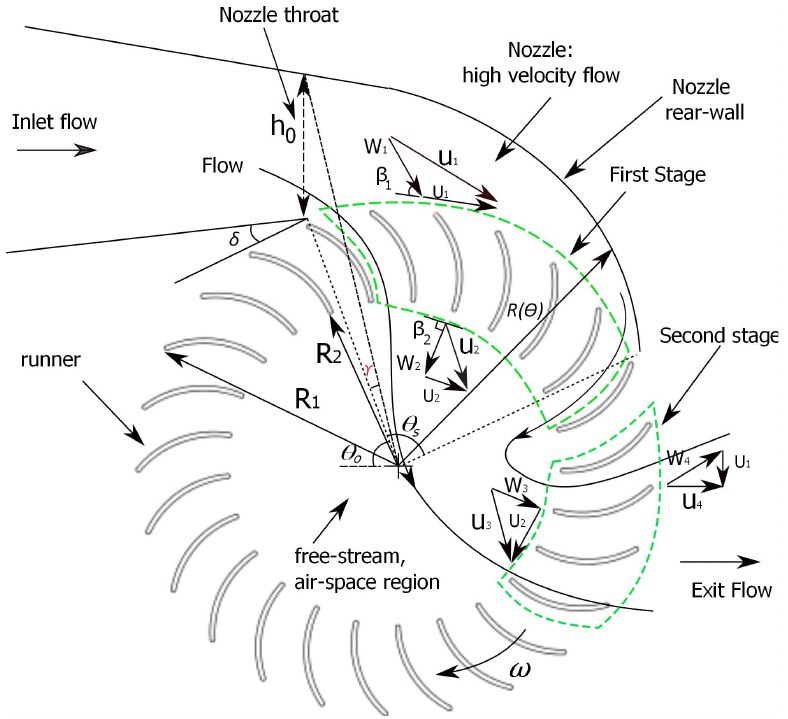
Figure 1. A schematic illustration of a single-nozzle crossflow